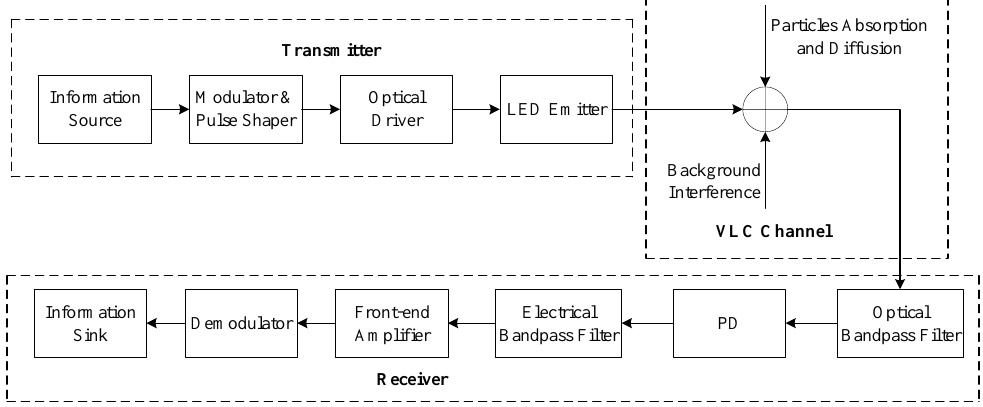
Figure 2. Architecture of a VLC